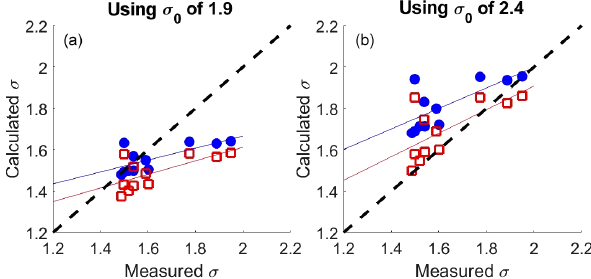
Figure 13. Scatterplots showing calculated and measured modal width ( σ) for biomass-burning plumes observed at MBO in Au- gust 2015. The blue circles represent σ calculated using Eq. (3) (d M/ d x ), and the red circles represent σ calculated using Eq. (4). (d M/ d x d z ). Different emission modal-width values ( σ 0 ) were used to calculate σ : (a) used a σ 0 of 1.9 and (b) used a σ 0 of 2.4.